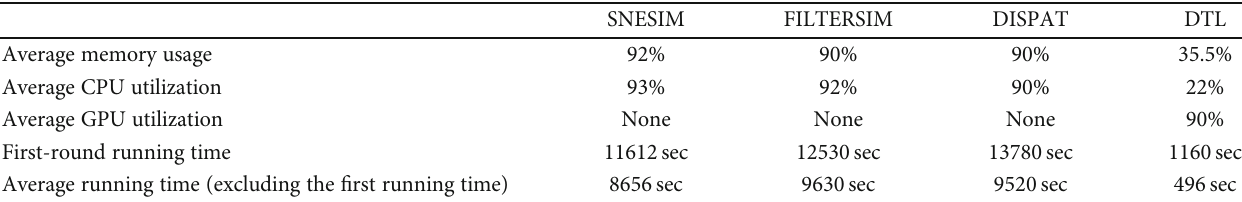
Table 8: The average memory usage, CPU/GPU utilization, and running time of SNESIM, FILTERSIM, DISPAT, and DTL for 10 reconstructions (shale).